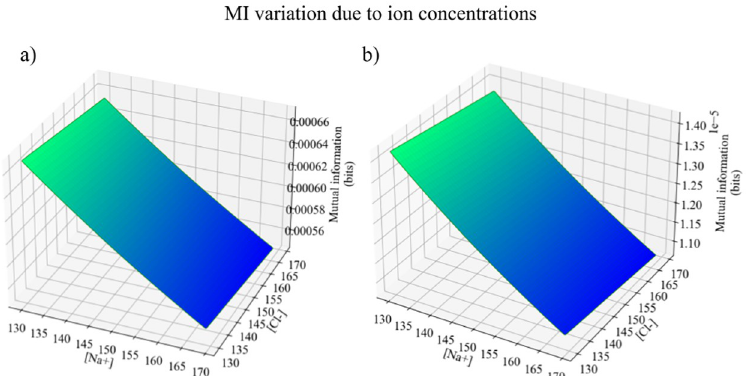
Fig 8. Variations in the mutual information value considering changes in sodium and chloride concentrations within their biophysical range. The baseline K + concentration was considered for a normally-distributed environment, since it is the most realistic distribution. Changes in MI are calculated in both (a) primitive conditions and (b) CSF conditions, as indicated in Table